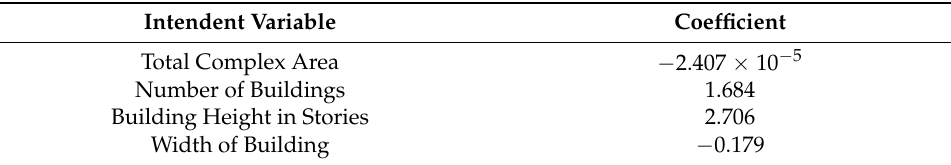
Table 9. Regression Coefficients for Envelope